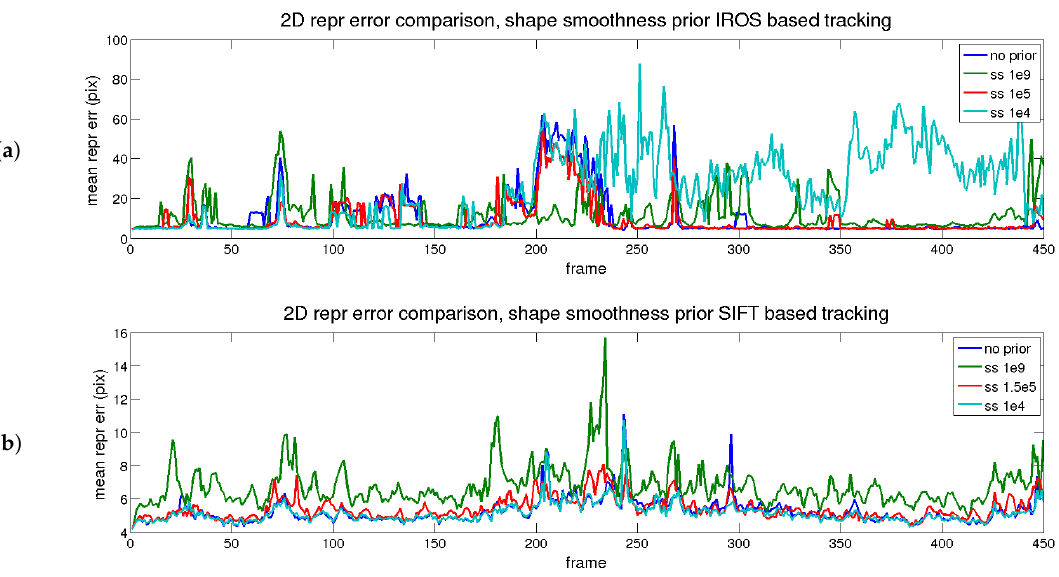
Figure 10. Rendered flag sequence: reprojection error over time with shape smoothness. Results are shown for two types of descriptors. ( a ) IROS; ( b ) SIFT.